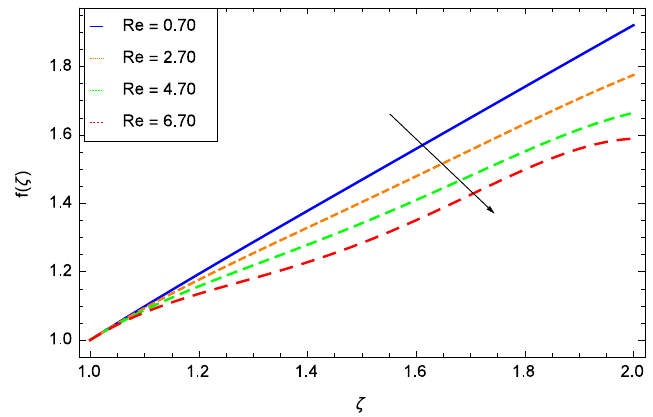
Figure 6. Non-dimensional velocity f ( ζ ) sketch for h = − 1.10, β 1 = 1.70, M = 0.10, φ = 0.04, Pr = 6.80 and greater quantities of Re (CuO-H 2 O).